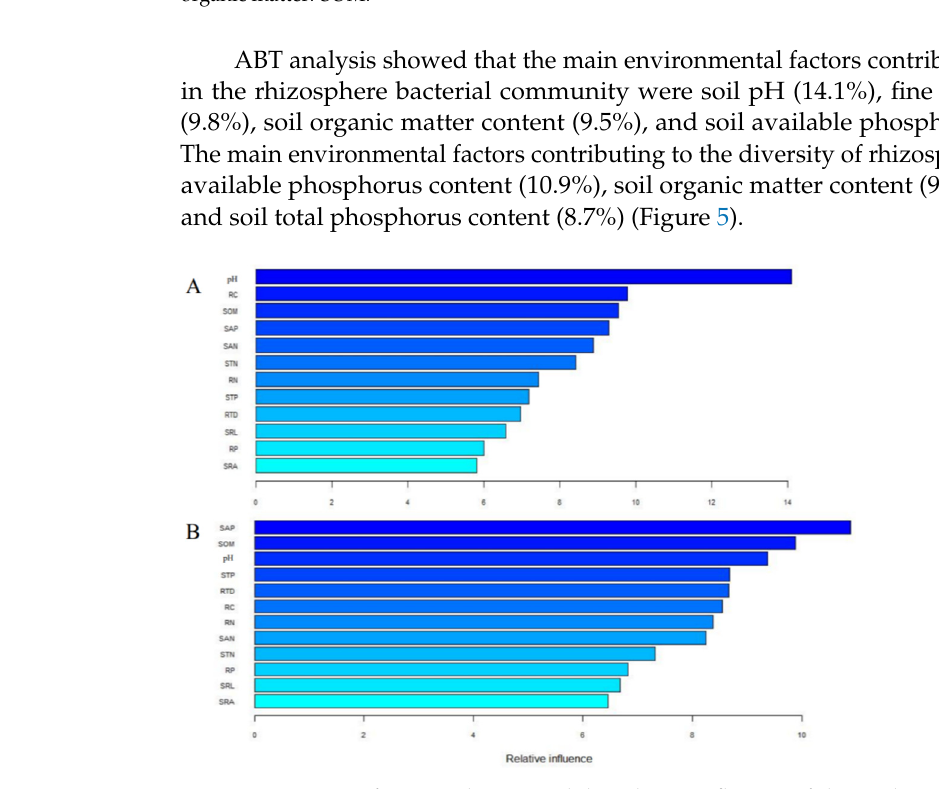
Figure 5. Fine root functional traits and the relative influence of rhizosphere soil on the diversity of rhizosphere microbial community (( A ) represents bacteria, ( B ) represents fungi; specific root length: SRL; root tissue density: RTD; specific root area: SRA; root carbon content: RC; root nitrogen content: RN; root phosphorus content: RP; soil pH: pH; soil total phosphorus: STP; soil available phosphorus: SAP; soil total nitrogen: STN; soil available nitrogen: SAN; soil organic matter: SOM.).